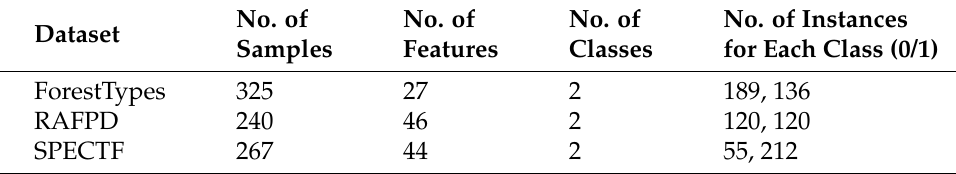
Table 5. The details of three benchmark datasets.